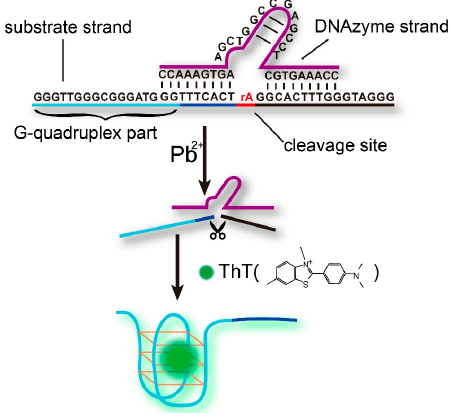
Figure 1. Illustration of the label-free fluorescent sensing strategy based on the Pb 2+ -DNAzyme and ThT/G-quadruplex complex.